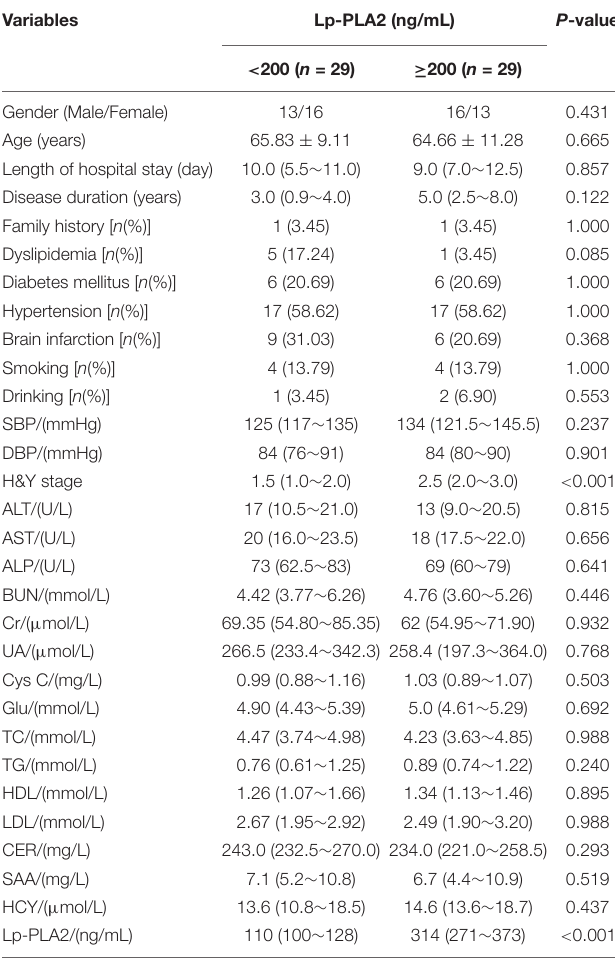
TABLE 4 | Baseline characteristics of patients with PD according to the levels of serum Lp-PLA2.